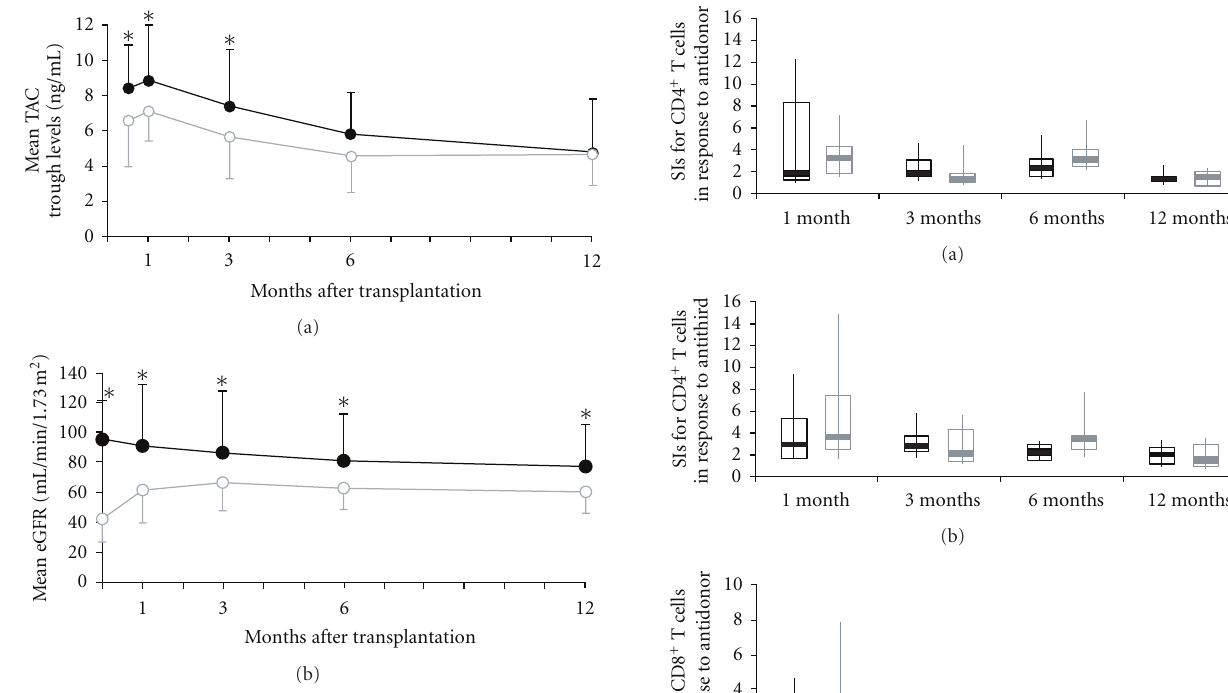
Figure 2: Kinetics of mean trough levels of tacrolimus and mean estimated glomerular filtration rate (eGFR) in the RI group and non-RI group during the first year after transplantation. (a) Mean trough levels of tacrolimus in the non-RI group (black line) and RI group (gray line). (b) Mean estimated glomerular filtration rate (eGFR) in the non-RI group (black line) and RI group (gray line). Data are median ± SD of values. ∗ P < 0 . 05.